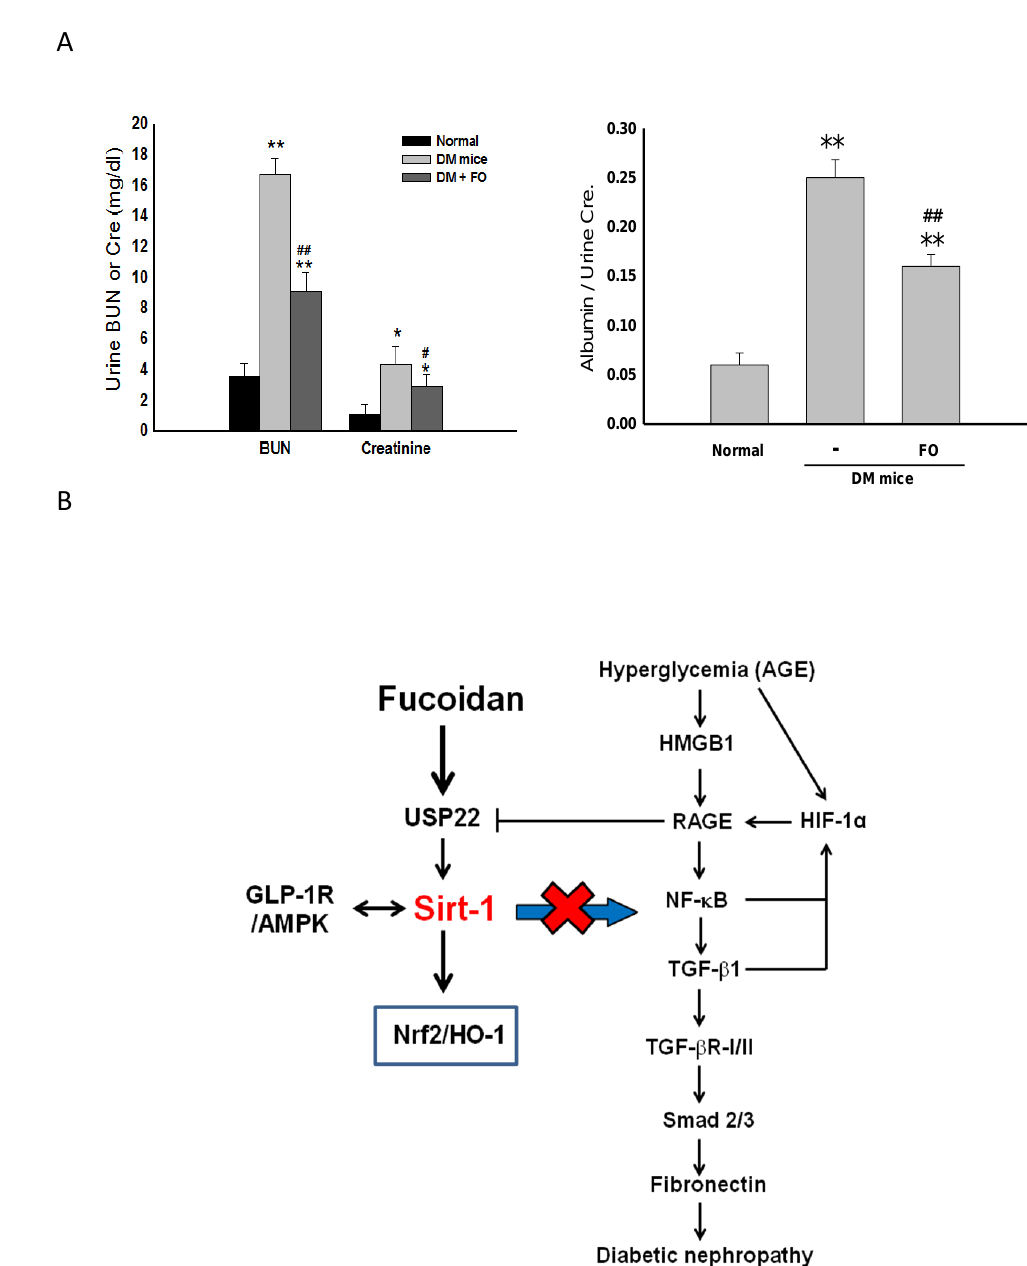
Figure6. Thee ff ectsoffucoidanonurinelevelsofBUN,creatinine, andalbumin, indiabeticnephropathy mice. After treatment with fucoidan (1) (300 mg / kg, p.o.) for 6 weeks, the urine levels of BUN, creatinine, and albumin were examined in di ff erent groups ( A ). Results were expressed as the mean ± SEM ( n = 8). * p < 0.05, ** p < 0.01 vs. normal mice; # p < 0.05, ## p < 0.01 vs. untreated diabetic mice. The proposed schematic diagram of the protective e ff ect of fucoidan against diabetic nephropathy ( B Figure 6